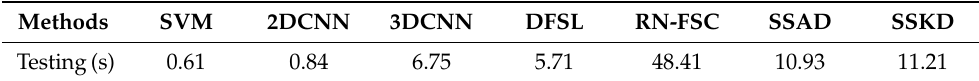
Table 9. Efficiency comparison on the testing phase of the compared methods (using UP dataset of five samples per